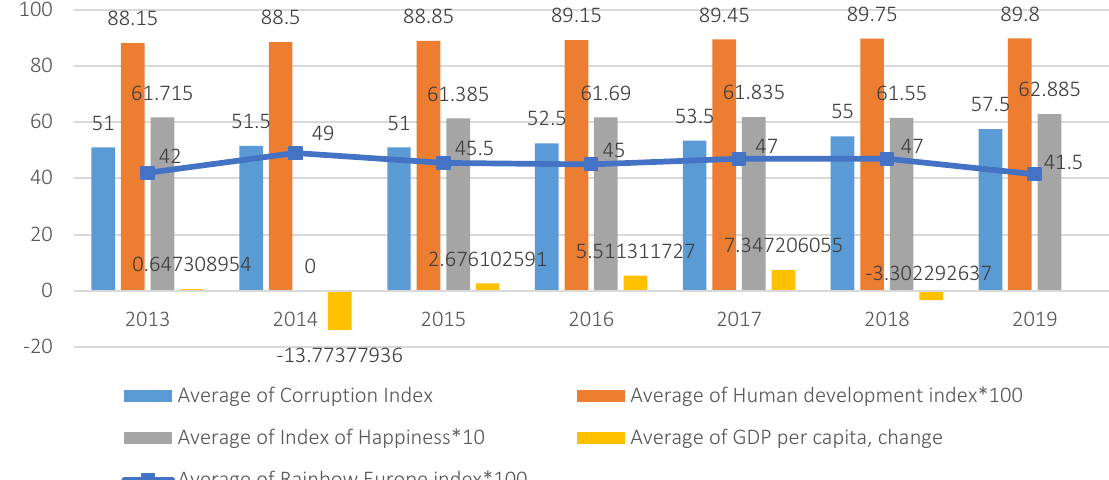
Figure 5. Average values of given indicators with a clear line of Rainbow Europe Index